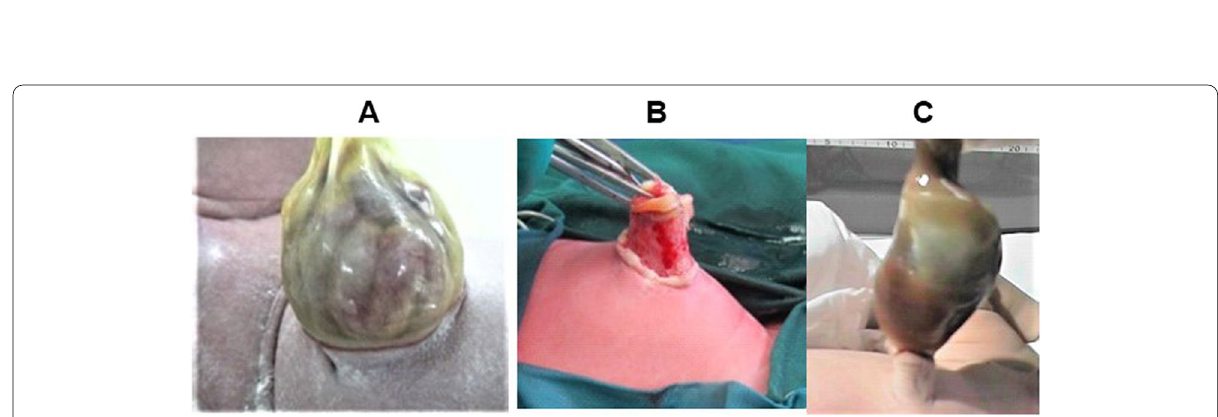
Fig. 2 Usual hernia of the umbilical cord (HUC) needed surgical intervention: A needed surgical repair due to broad base; B needed surgical repair due to long neck of skin at the base of HUC, on suturing of proximal end of the sac, long umbilical hernia like swelling remains projecting, had stage surgical repair, C hemorrhagic fluid seen in the sac upon manual reduction then under sedation, surgical exploration of the sac was done, revealed clotted blood content only then clamping of the neck of the sac was sufficient